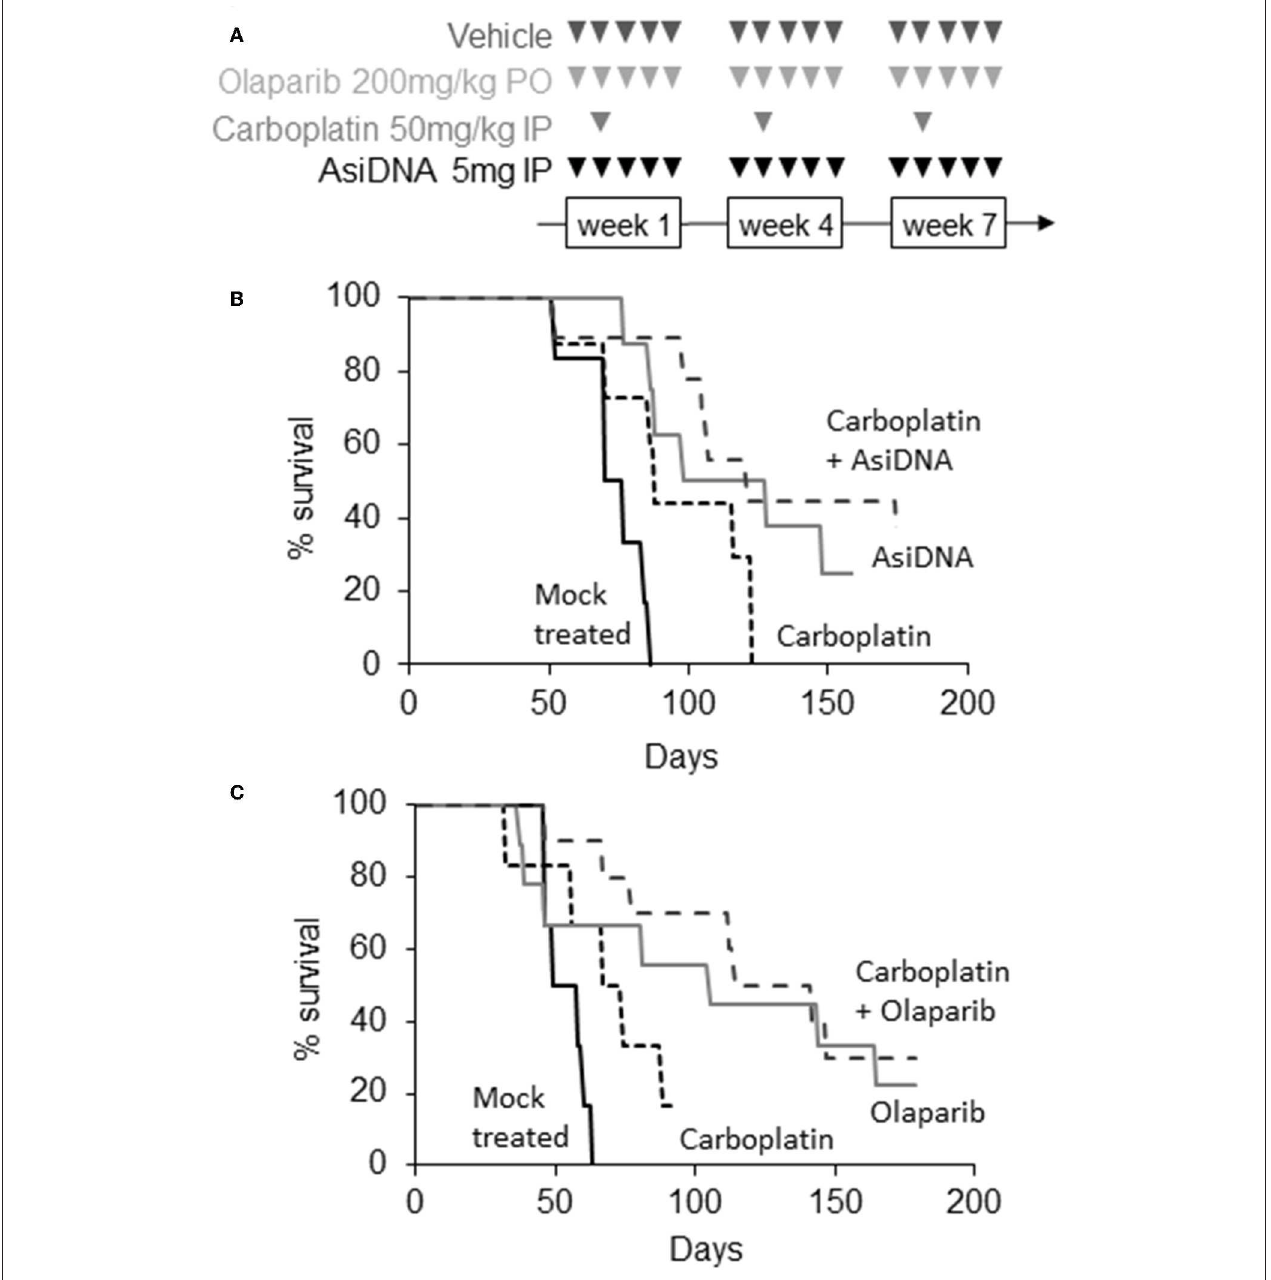
FIGURE 2 | Efficacy of combination treatments. (A) Scheme of different treatments, triangles indicate days of treatment; (B,C) Kaplan–Meier representation of two independent experiments. Survival was calculated as the fraction of living animals with tumor size < 1,500 mm 3 ; (B) mock treated ( n = 6, black), treated with carboplatin ( n = 8, small dotted black), AsiDNA ( n = 8, gray), or combination of AsiDNA and carboplatin ( n = 10, large dotted black); (C) mock treated ( n = 6, black), treated with carboplatin ( n = 6, small dotted black), olaparib ( n = 9, gray), or combination of olaparib and carboplatin ( n = 10, large dotted black).